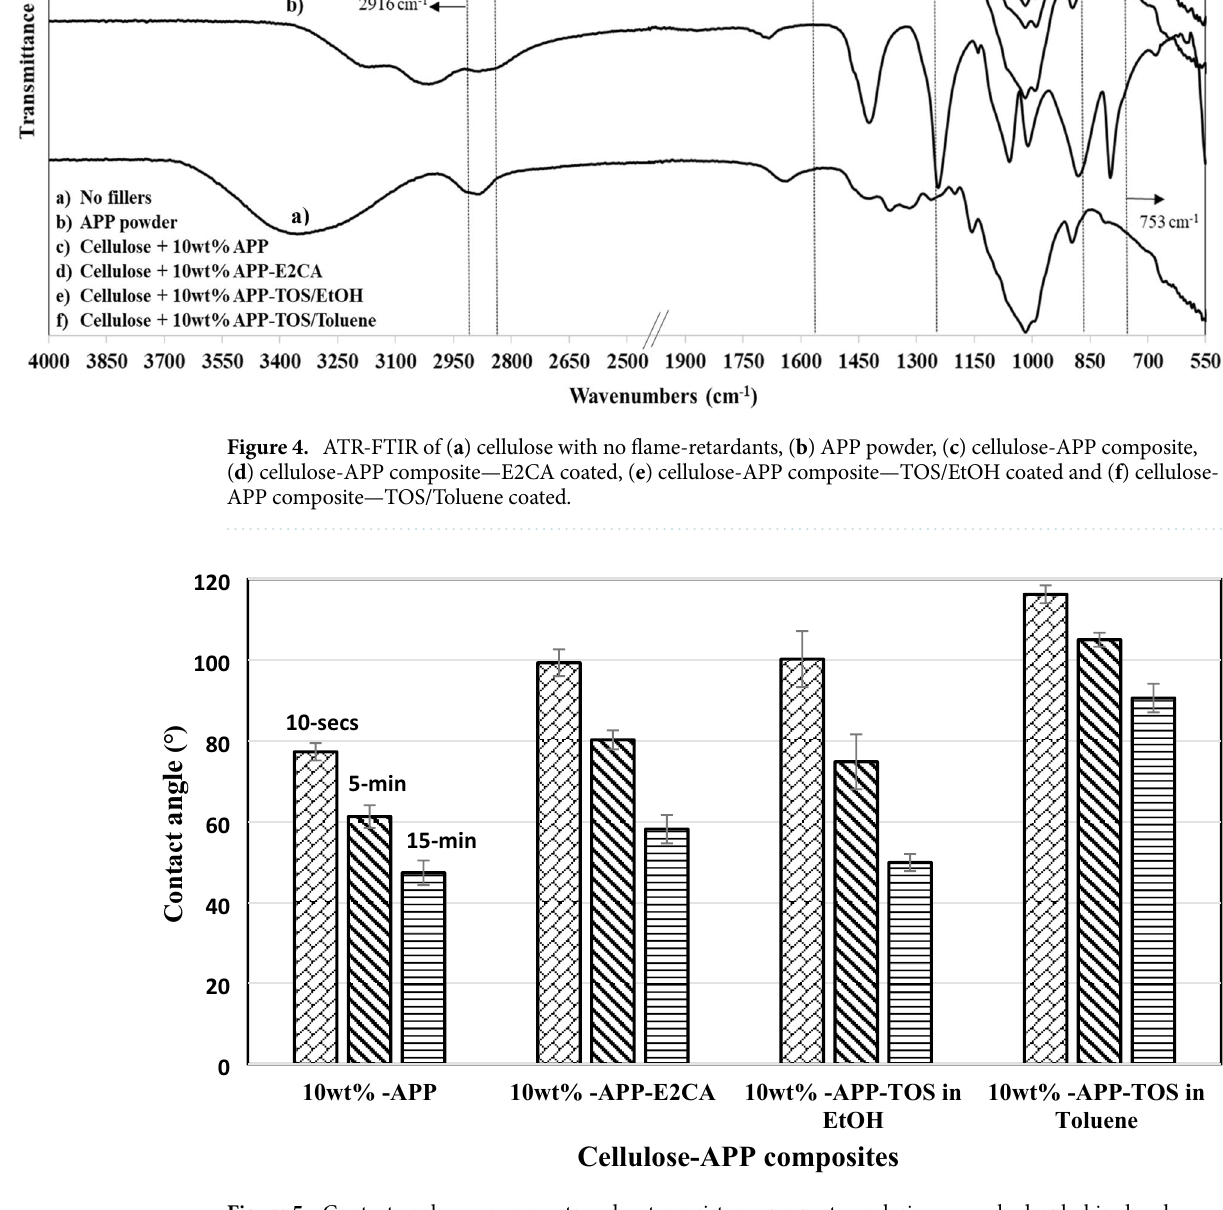
Figure 5. Contact angle measurements and water resistance property analysis on non-hydrophobised and hydrophobised cellulose-APP